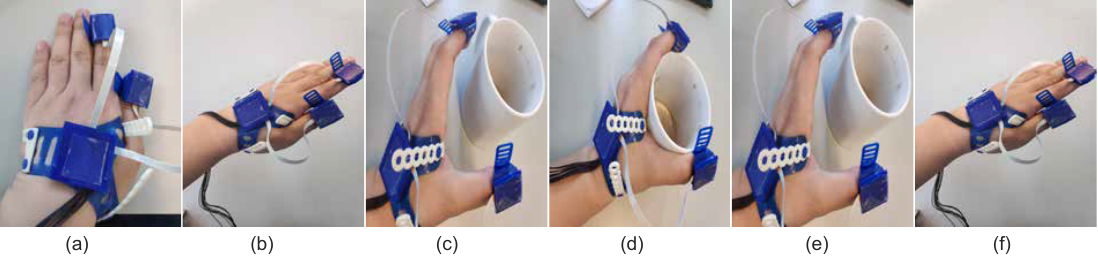
Figure 3. Movement for task 2: Simple functional task. The task can be divided into several phases. ( a ) Put the hand static on the desk; ( b ) raise the hand; ( c ) grasp the cup; ( d ) drink the water; ( e ) release the hand; ( f ) withdraw the